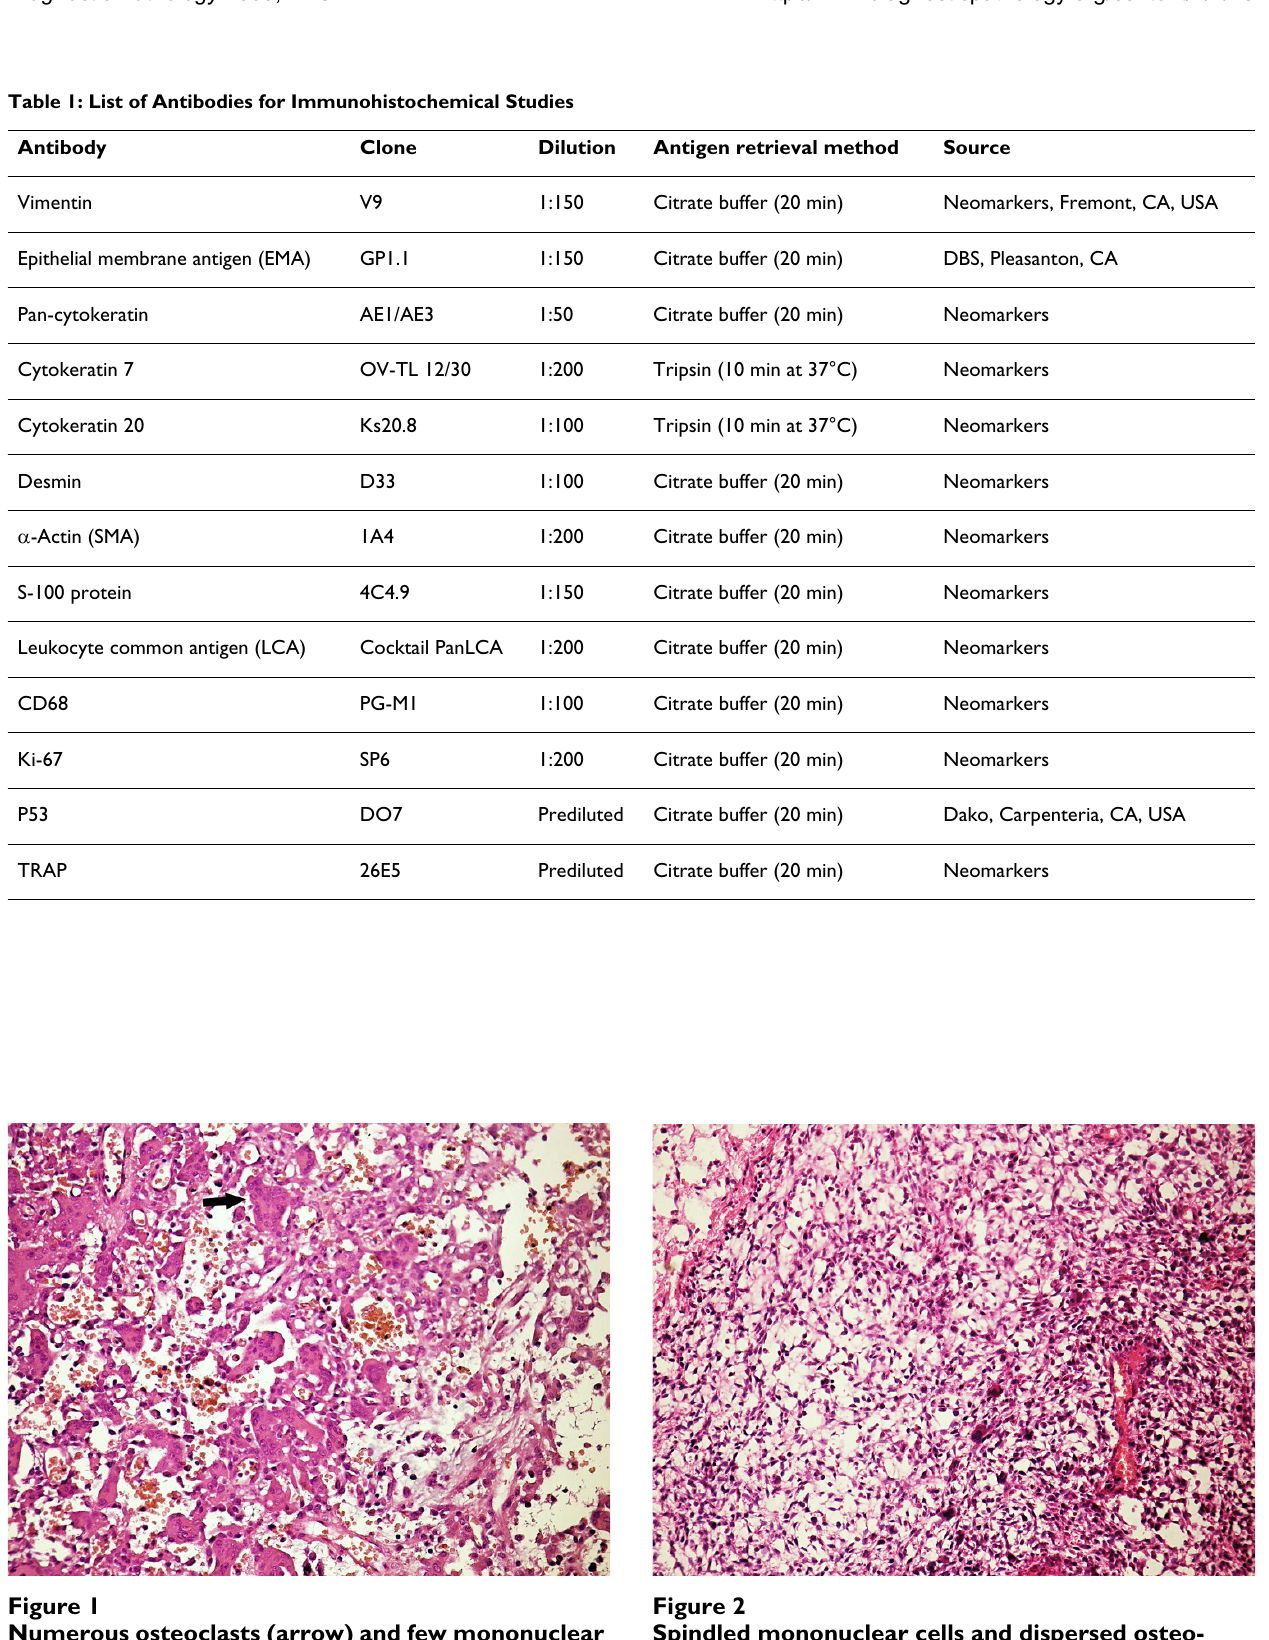
Numerous osteoclasts (arrow) and few mononuclear cells between blood lakes in Case 2. (H&E, × 300) .